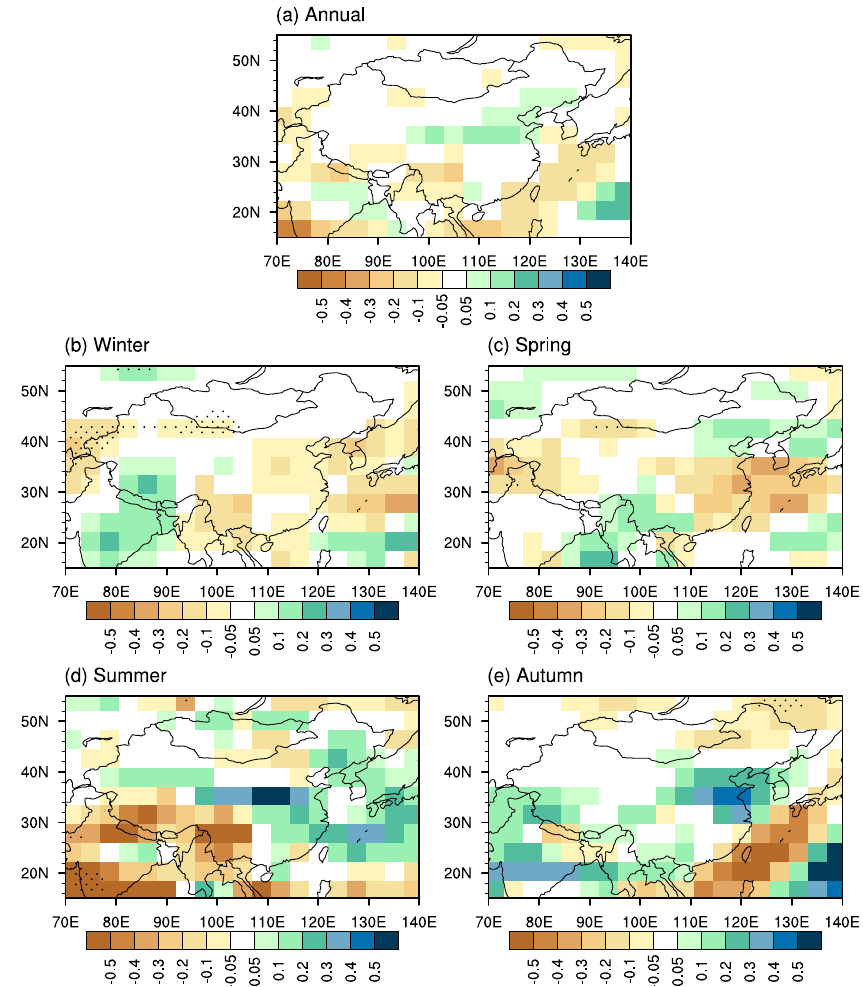
Fig. 11. Annual and seasonal precipitation changes (units:mmday − 1 ) between (AOV(6ka)–AOV(0ka)) and (AO(6ka)–AO(0ka)) experi- ments. The areas exceeding 90% confidence level are